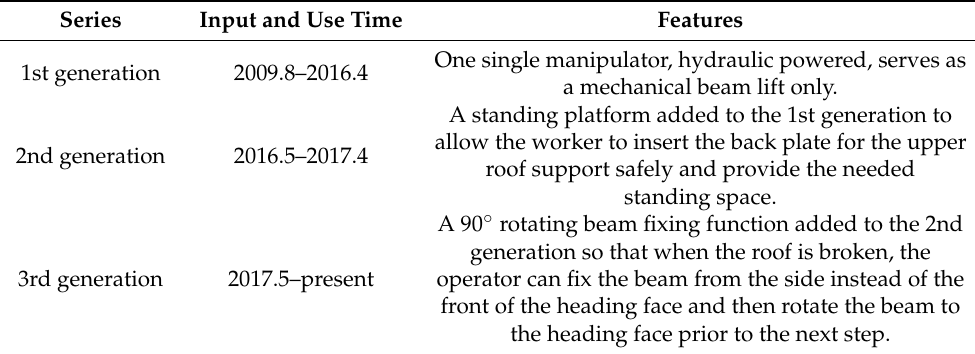
Table 3. The development and application history of the combined onboard standing platform + onboard beam lift